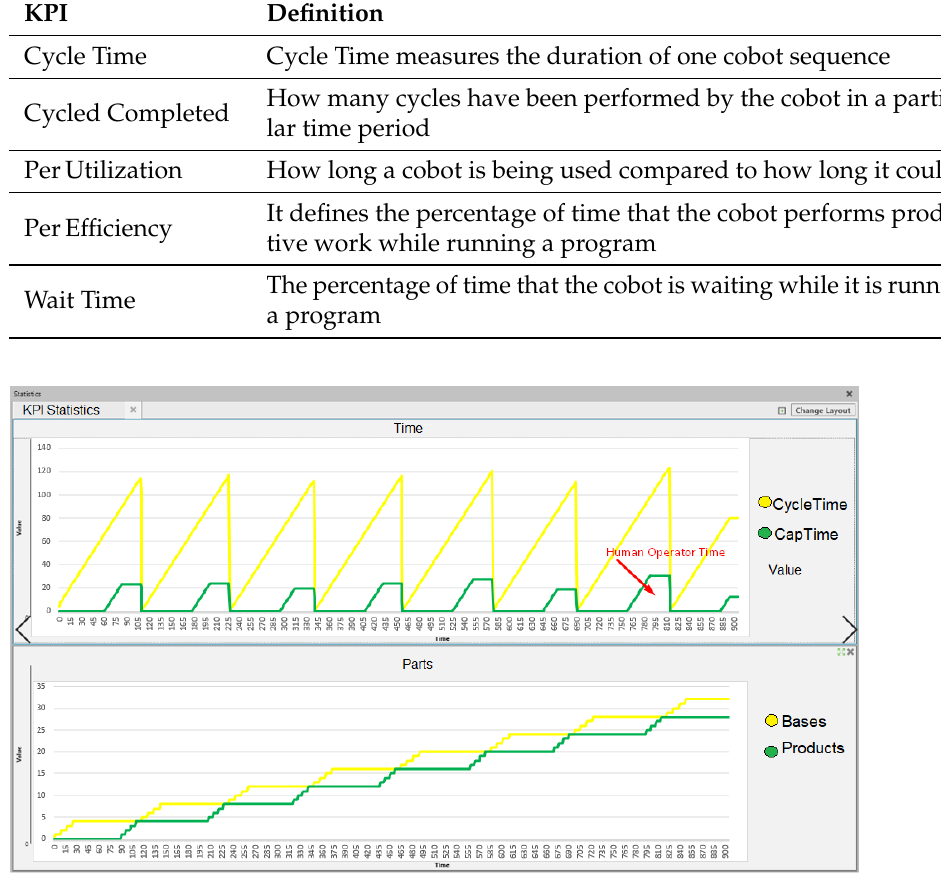
Figure 8. Time data and raw material sent from cobot